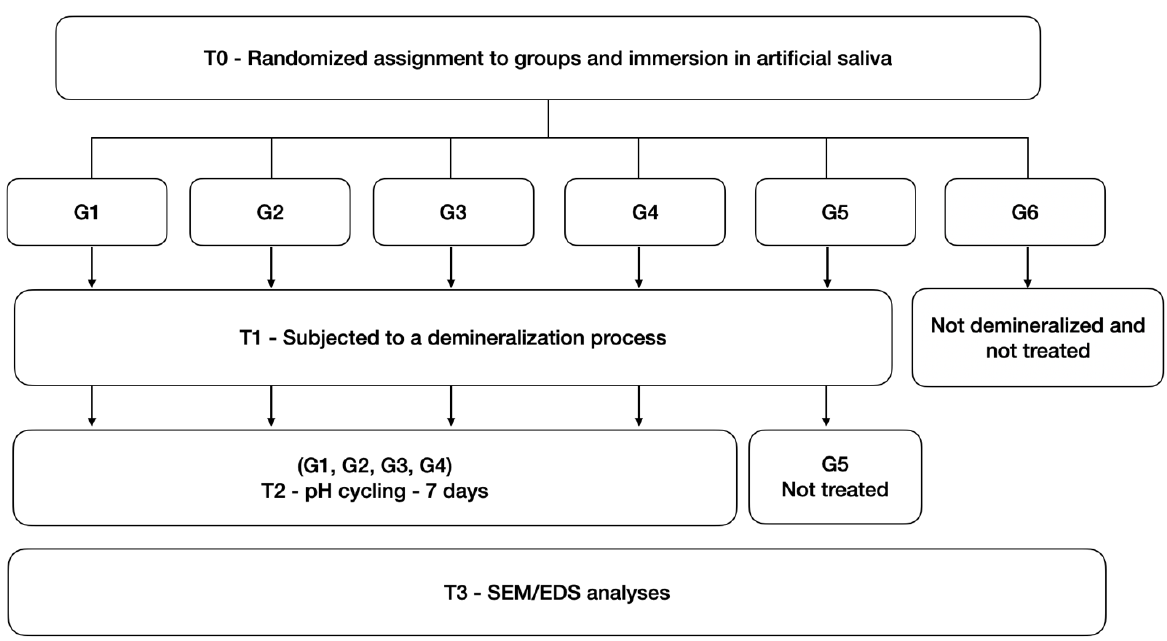
Figure 1. Schematic representation of experimental study design. G1 (Mousse Group), G2 (Nano- Hydroxyapatite Group), G3 (Duraphat Group), G4 (Biosmalto Group), G5 (group treated with the demineralizing solution), G6 (group without any treatment).